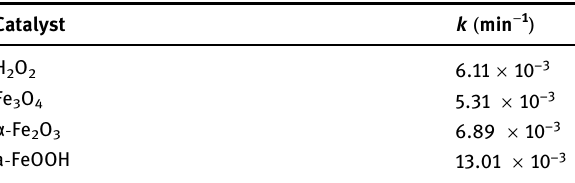
Table 2: Kinetic constants for pseudo fi rst - order kinetics in the photo - Fenton - like discoloration of MB Catalyst